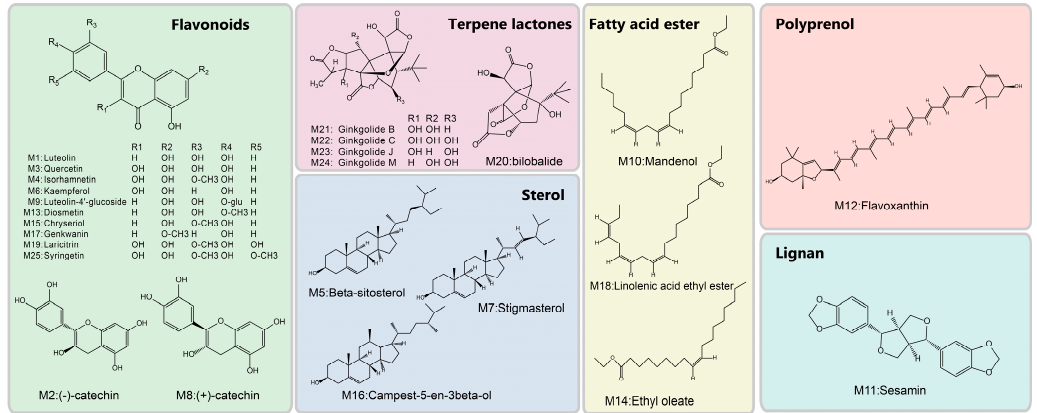
Figure 2. The 2D molecular structures, names, and codes of the 25 candidate compounds.